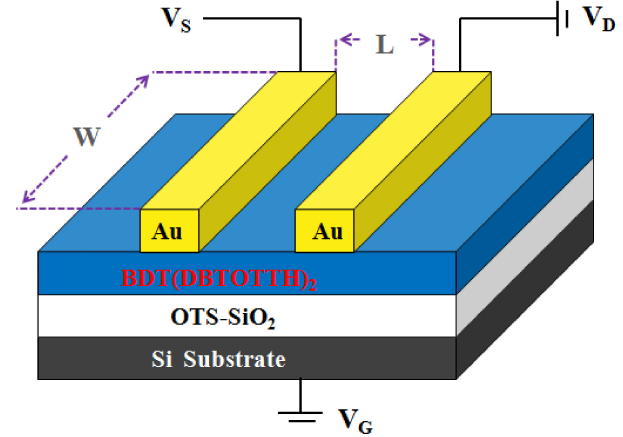
Figure 3. Schematic configuration of the top contact OFET device based on BDT(DBTOTTH) 2